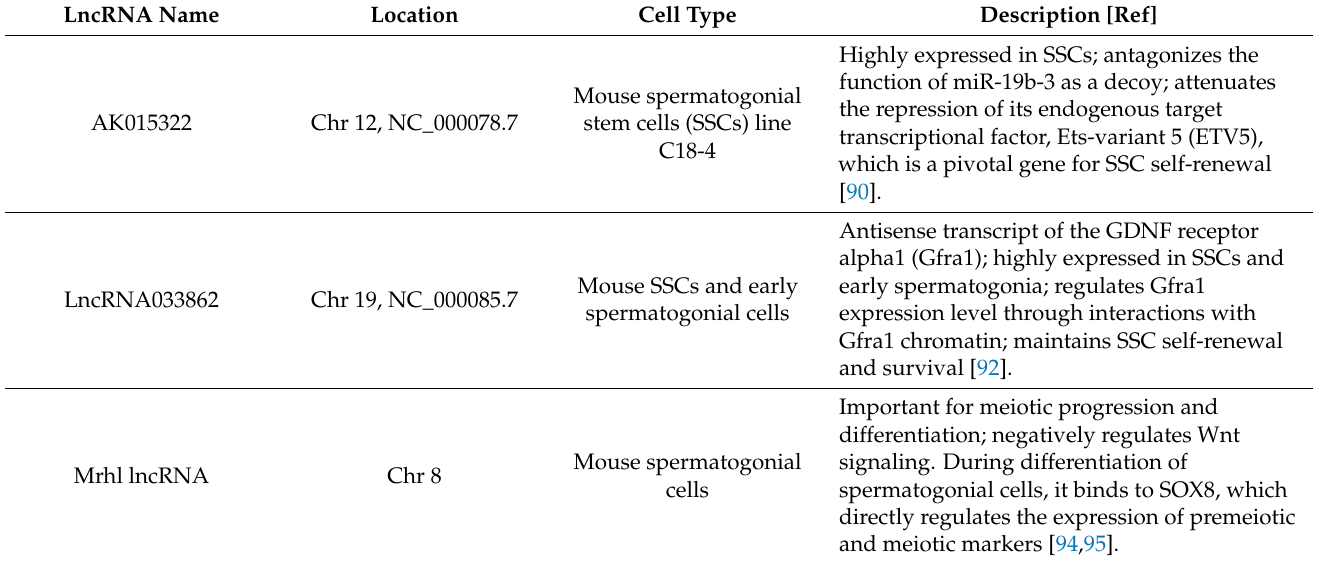
Table 2. Recent findings relating to long noncoding RNAs (lncRNAs) and their potential as biomarkers and therapeutic